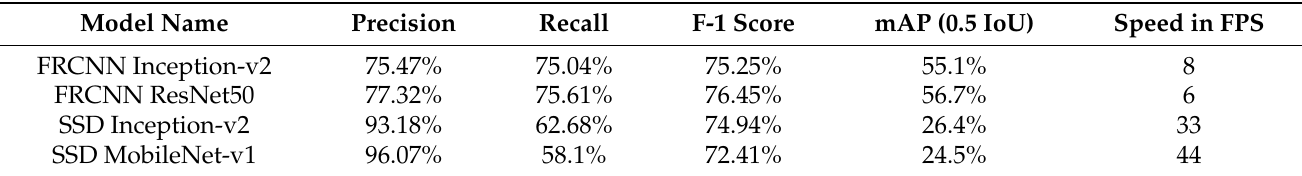
Table 2. The performance of various object detection models for the validation dataset.